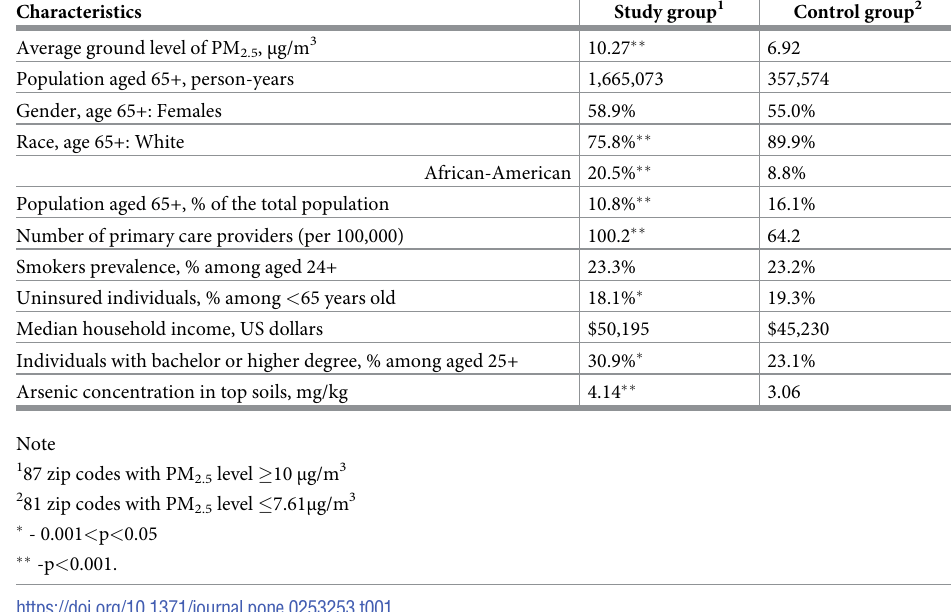
Table 1. Descriptive table of the studied populations: NC, 2007–2014.